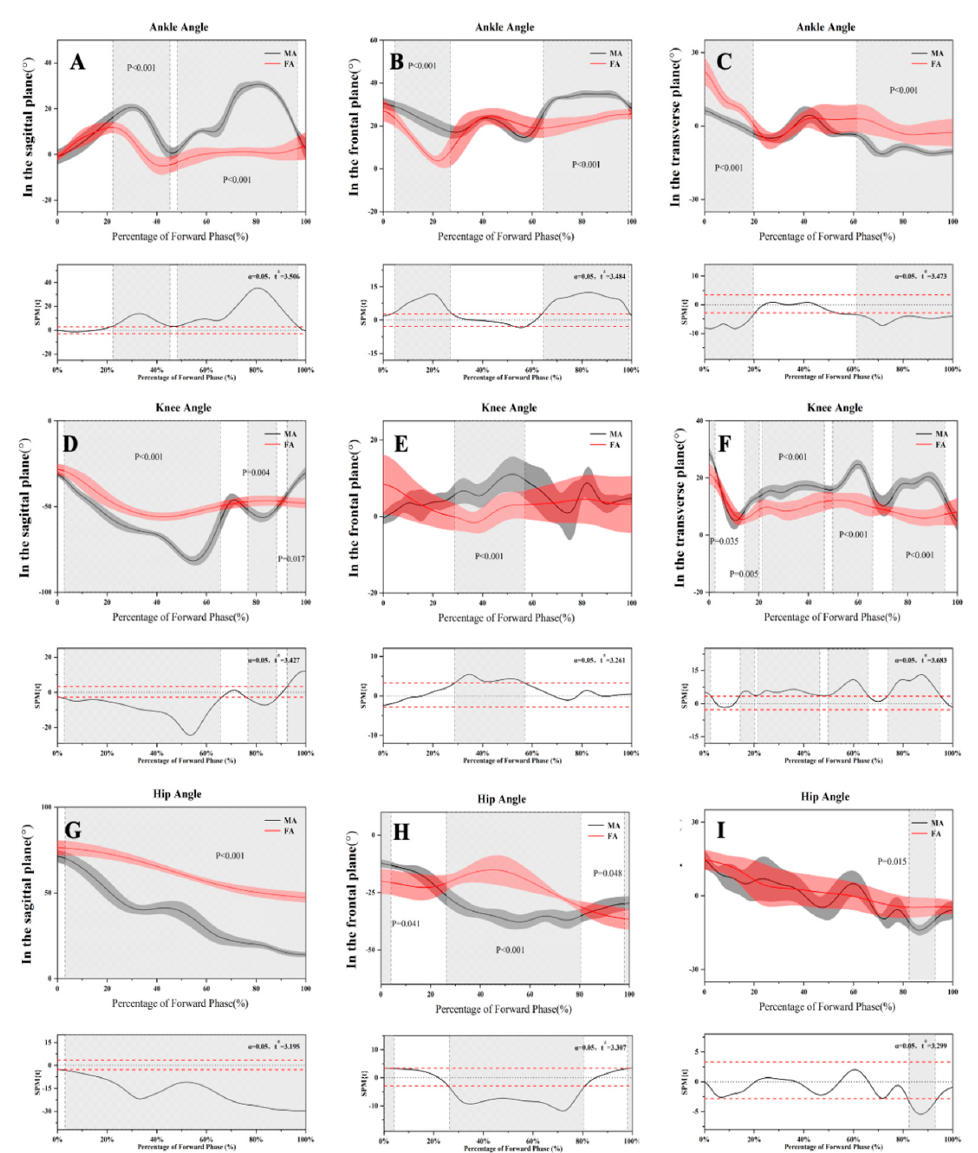
Figure 4. Changes of the lower limb joint angles during the forward phase in three planes. ( A – C ) Ankle angle changes during the FP in three planes. ( D – F ) Knee angle changes during the FP in three planes. ( G – I ) Hip angle changes during the FP in three planes.